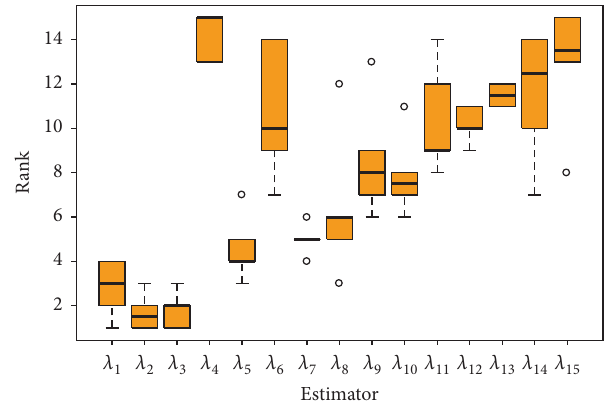
Figure 6: Box-plot representing the ranks of each estimator, based on the results for the six Pittosporum undulatum plots. A high rank (i.e., a maximum of 1) indicates that a particular estimator was closest to the benchmark more